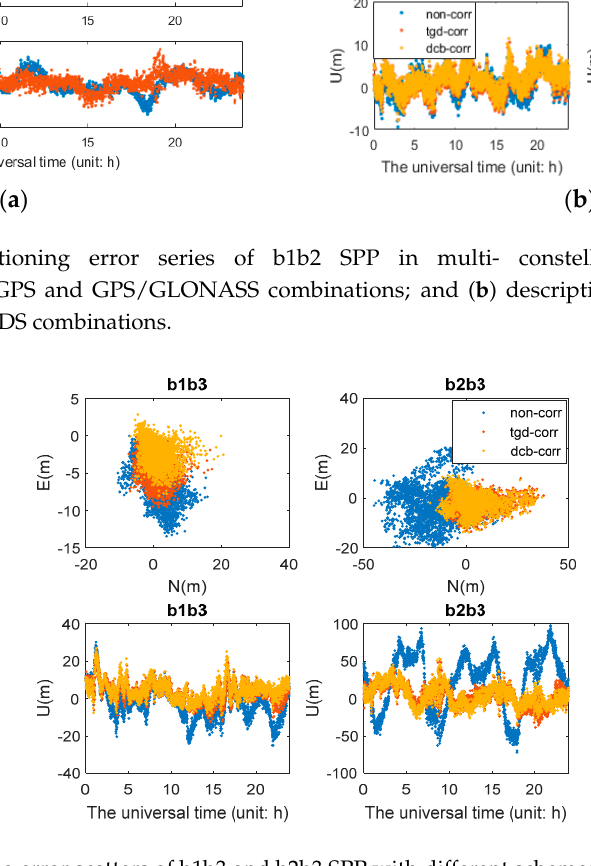
Figure 6. Positioning error scatters of b1b3 and b2b3 SPP with different schemes in G/C constellation combinations. For each plot, the upper and lower plots represent, respectively, horizontal positioning error scatters and Vertical positioning error scatters. Table 4. RMS of dual-frequency standard point positioning (unit: